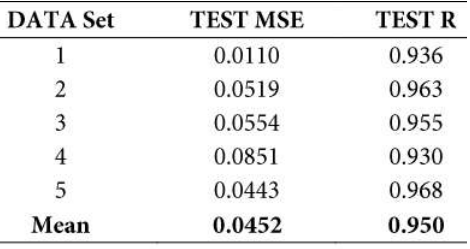
Table 4. Results of MSE and linear regression in tests